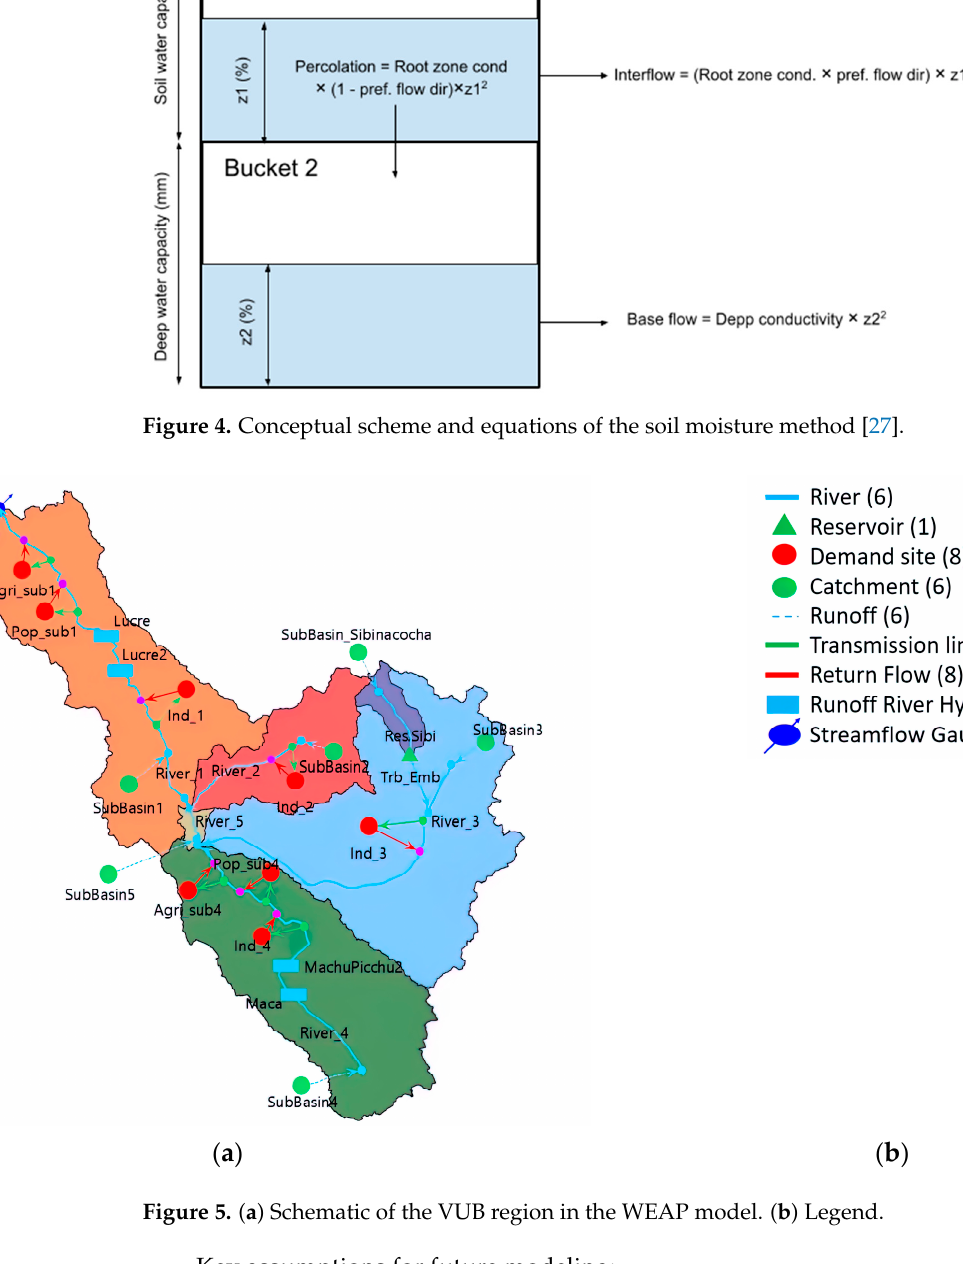
Figure 4. Conceptual scheme and equations of the soil moisture method [27].